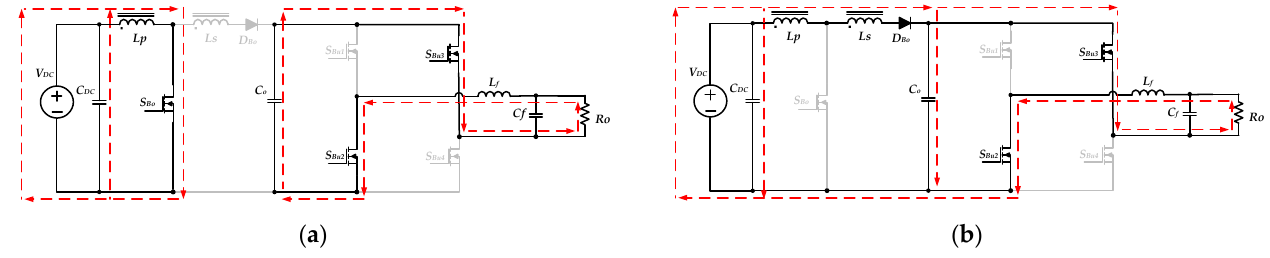
Figure 10. The equivalent circuits of the inverter operating in step-up mode during the negative half cycle: ( a ) S Bo on; ( b ) S Bo off.